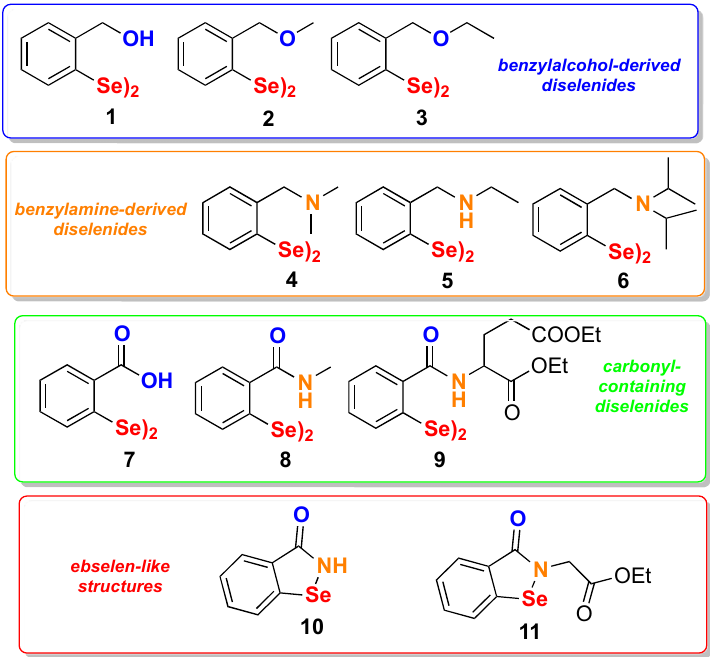
Figure 2. Collection of compounds selected for this study.